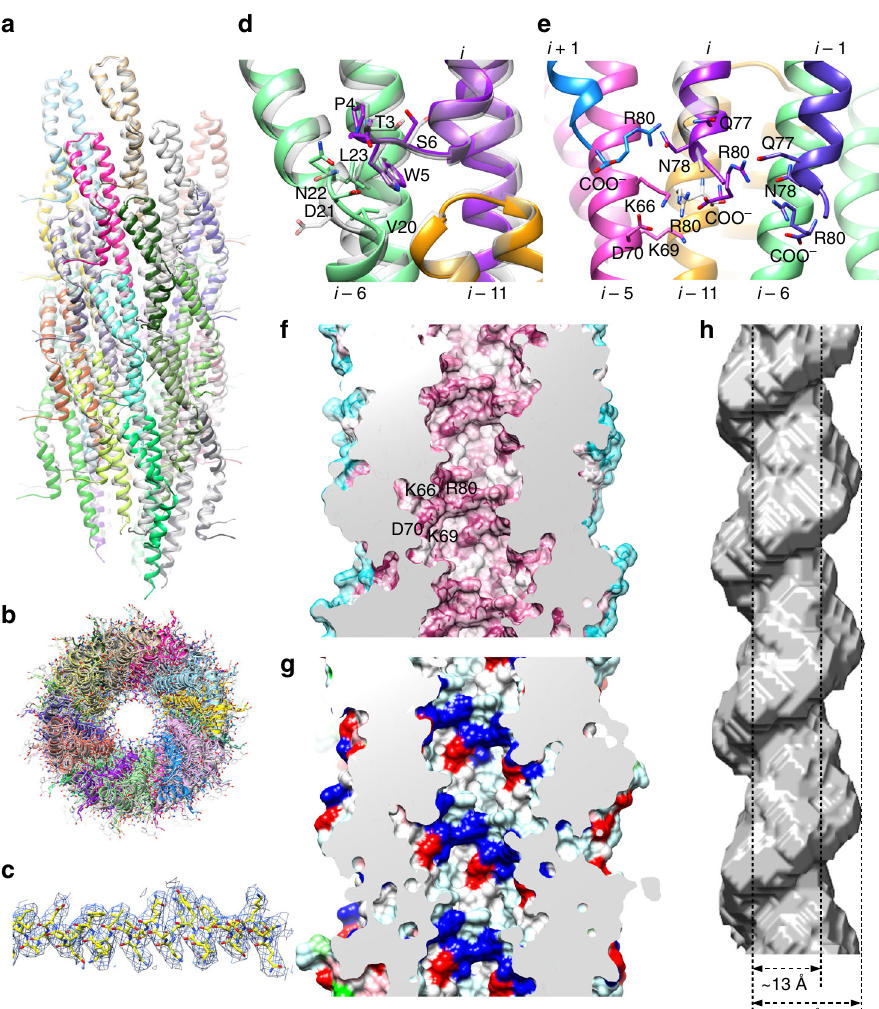
Fig. 3 Structure of the PrgI needle fi lament at 3.3 Å de fi nes a spiral groove for effector secretion. a , b Side and top views of the helical packing of the PrgI needle with 5.7 monomers per turn and a helical rise of 4.33 Å. The ssNMR structure of PrgI (PDB 2LPZ; gray transparent) is overlaid showing the subtle differences in helical parameters create a small but accumulating change in subunit packing. Side chains, resolved in the reconstruction here, are shown in b highlighting the constriction of the interior channel. c Representative density (3.3 Å resolution). d Zoomed in view showing interface of i, i − 6, and i − 11 monomers formed around the N-terminal loop of i . The ssNMR structure of PrgI (gray transparent) is overlaid. The variable N-terminal loop here is packed closer to the kinked helix of monomer i − 6. The kink (residues 20 – 23) adopts a different conformation compared to the ssNMR structure. e Zoomed view of the interaction network around the C-terminal Arg 80 . The ssNMR structure is overlaid on monomer i showing the Arg 80 side chain and carboxylate in a fl ipped orientation. Here, the Arg i – 1 while the carboxylate interacts with Lys 80 side chain guanidinium group interacts with Gln 77 and Asn 78 on monomer 66 on i – 5. f The interior channel is signi fi cantly more conserved than the outer surface (conservation colored from cyan (low) to maroon (high)). The cluster of conserved residues around the C-terminus as in e de fi ne the raised edge of a right handed spiral that extends the length of the lumen. The groove is lined by repeating deeper pockets de fi ning the path of effector secretion. g Same view as in f colored according to residue type: hydrophobic – gray, aromatic – light pink, polar – light cyan, positive – blue, negative – red, cysteine – light yellow, proline – light green, glycine – green. The raised edge of the groove is demarcated by charged residues while the groove itself is predominantly polar and hydrophobic. h Surface corresponding to the interior needle lumen highlighting the right handed spiral and dimensions of the